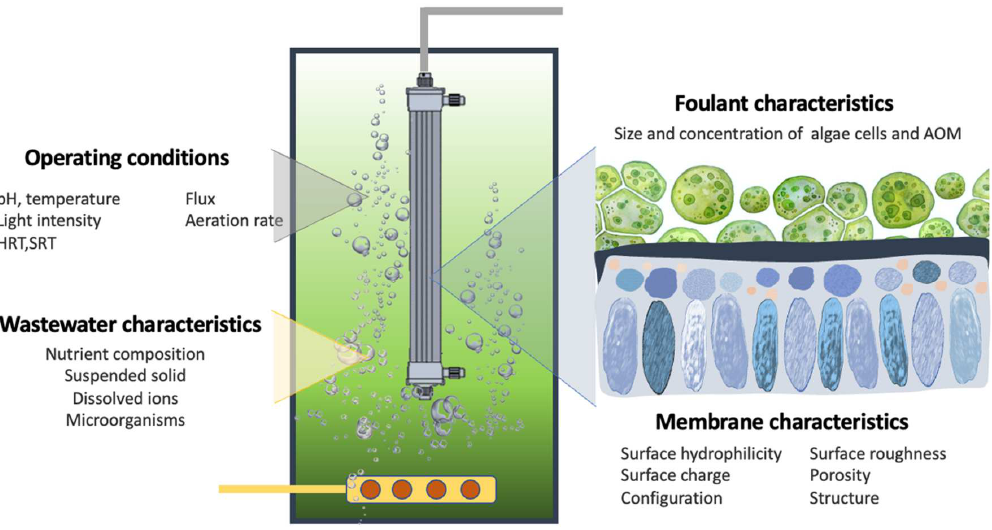
Figure 3. The major fouling-contributing components during wastewater treatment in microalgae- containing MPBRs.